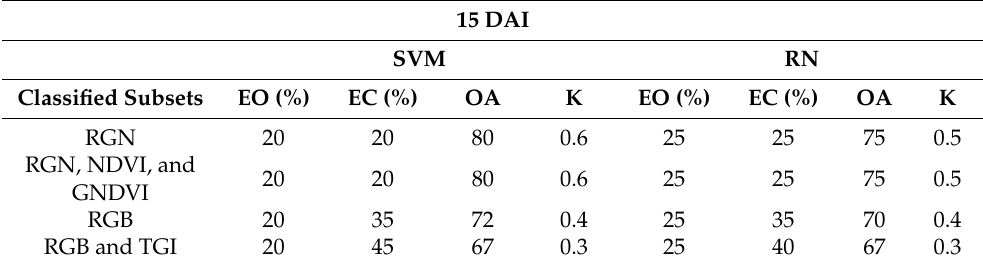
Figure 9. Spectral response of inoculated and non-inoculated coffee seedlings at 15, 30, and 45 days after inoculation (DAI) based on the average reflectance values of the RGB sensor images (red, green, and blue bands). Table 2. Supervised classification of inoculated and non-inoculated coffee seedlings with H. vastatrix , 15 days after inoculation (DAI).